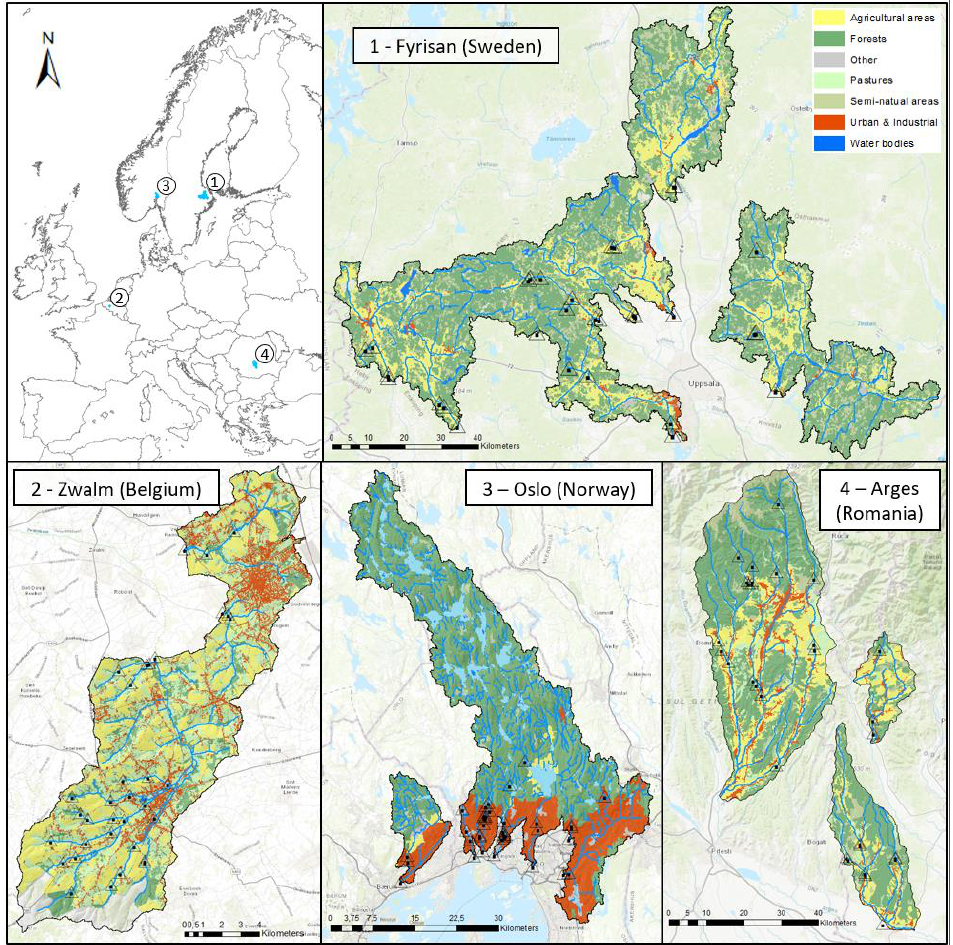
Figure 1. Map of Europe showing the locations of the four case-study basins used in the CROSSLINK project: 1) Sweden (forested and agricultural stream reaches in the Lake Mälaren basin), 2) Belgium (forested, agricultural and urban reaches in the Zwalm river basin), 3) Norway (forested and urban stream reaches in the Oslo Fjord basin), and 4) Romania (forested and agricultural reaches in the Argeş river basin). Table 1. Glossary of key terms related to the CROSSLINK